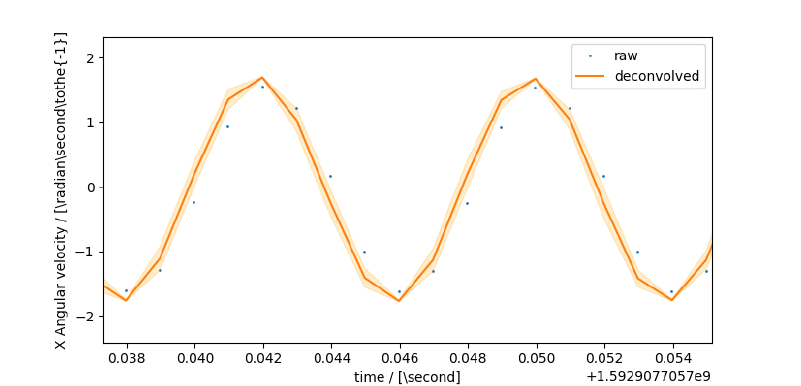
Figure 5. Implemented example: Comparison of the incoming (raw) and processed (deconvolved) signal. Note that the processed signal shows an increase in amplitude that corresponds to Figure